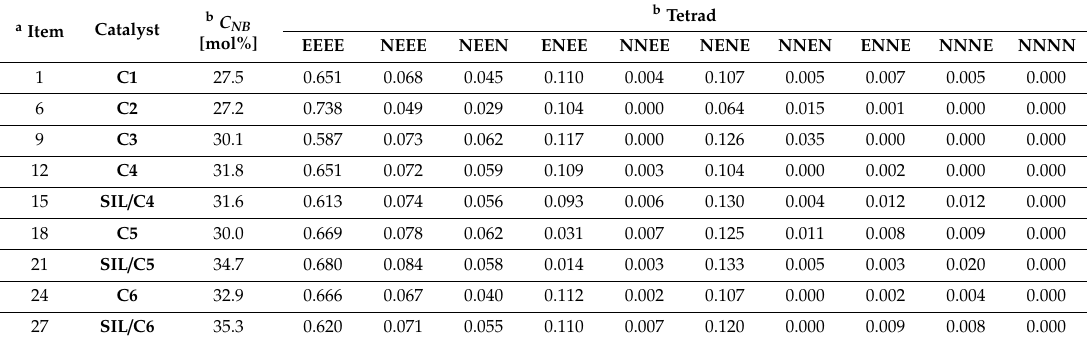
Table 2. Tetrad distributions of E-NB copolymers obtained over different homogeneous and SIL catalyst systems.